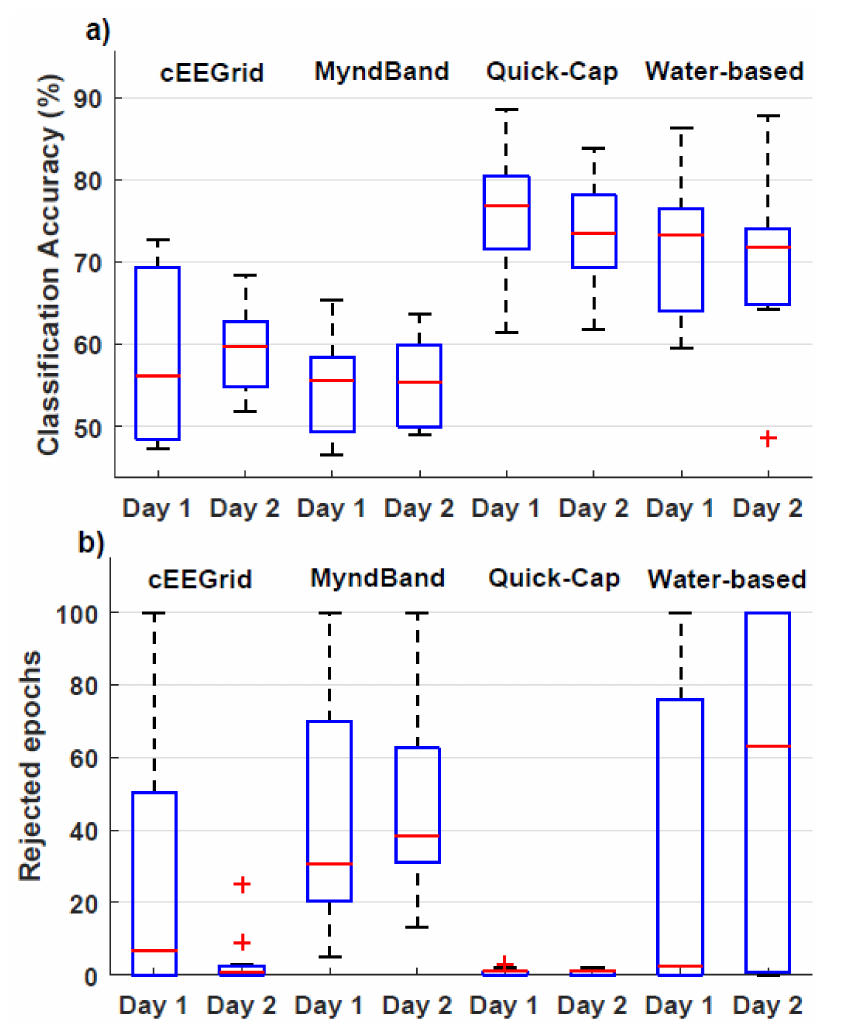
Figure 4. Boxplots with quartiles for the classification accuracies ( a ) and number of rejected epochs ( b ).